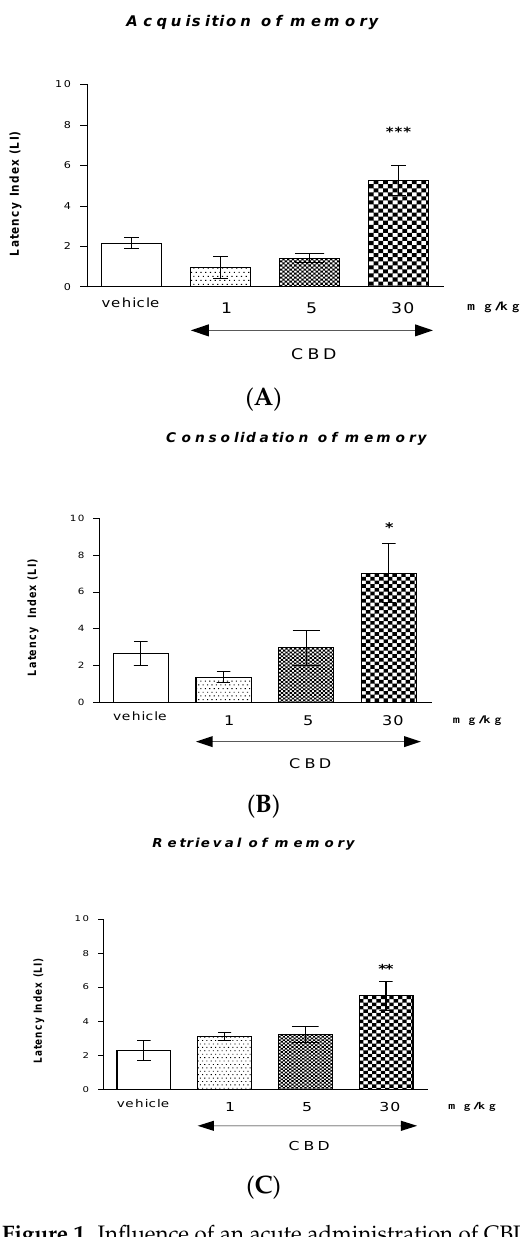
Figure 1. Influence of an acute administration of CBD on the cognition-related responses, expressed as latency index (LI), during the acquisition ( A ), consolidation ( B ), and retrieval ( C ) of memory using the PA test in mice. CBD (1, 5, or 30 mg/kg) or vehicle were administered 30 min before the first trial (acquisition of memory), immediately after the first trial (consolidation of memory), or 30 min before the second trial (retrieval of memory). The second trial was conducted 24 h after the first; n = 8 – 10; the means ± SEM; * p < 0.05; ** p < 0.01; *** p < 0.001 vs. vehicle-treated group; Tukey’s test.